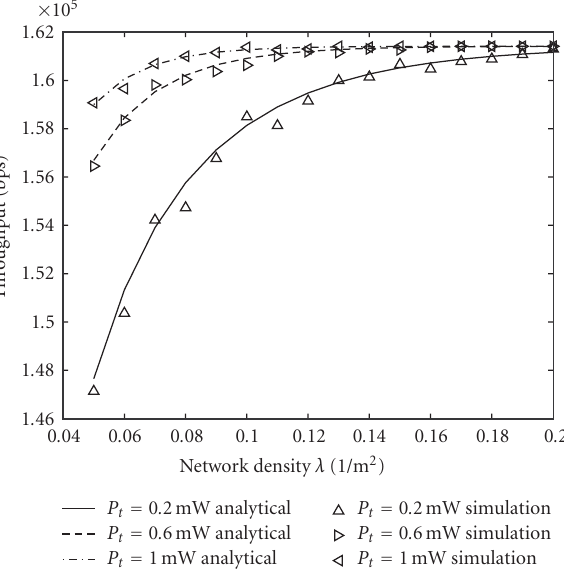
Figure 7: Throughput versus network density λ ( l = 160 m).